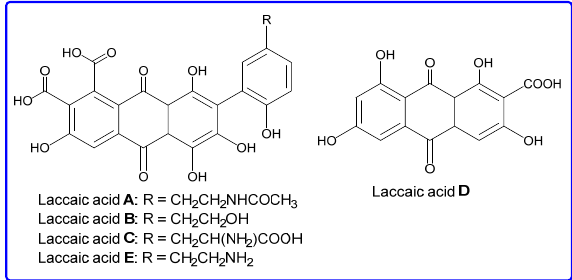
Figure 2. Structures of laccaic acids (natural dyes).